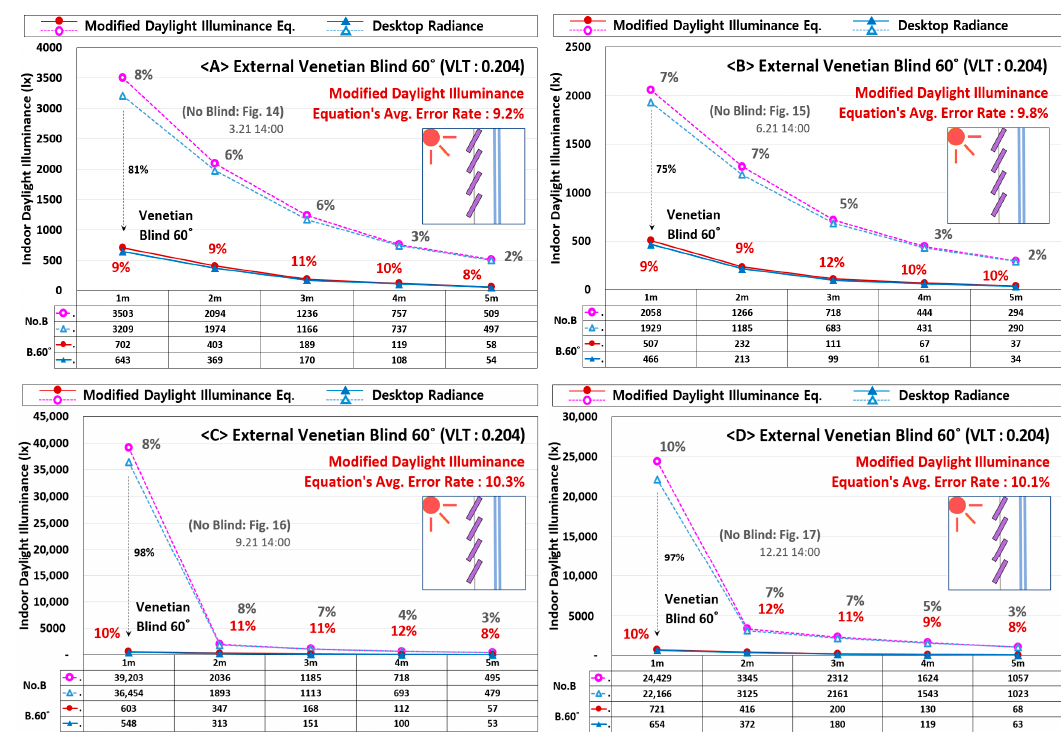
Figure 24. Comparison of indoor illuminance between the modified equation and Desktop Radiance simulation when installing external venetian blind 60° ( A ) 3.21 ( B ) 6.21 ( C ) 9.21 ( D ) 12.21 (14:00).